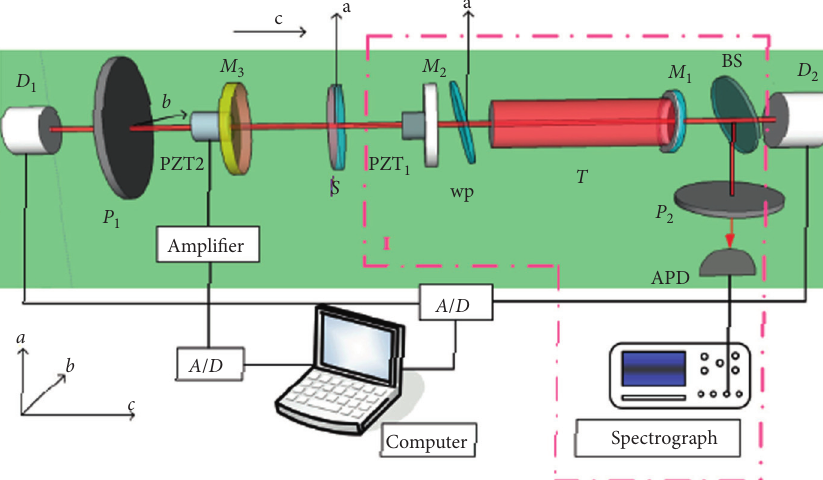
Figure 9: The schematic diagram of the experimental setup of LFDSI system [35].